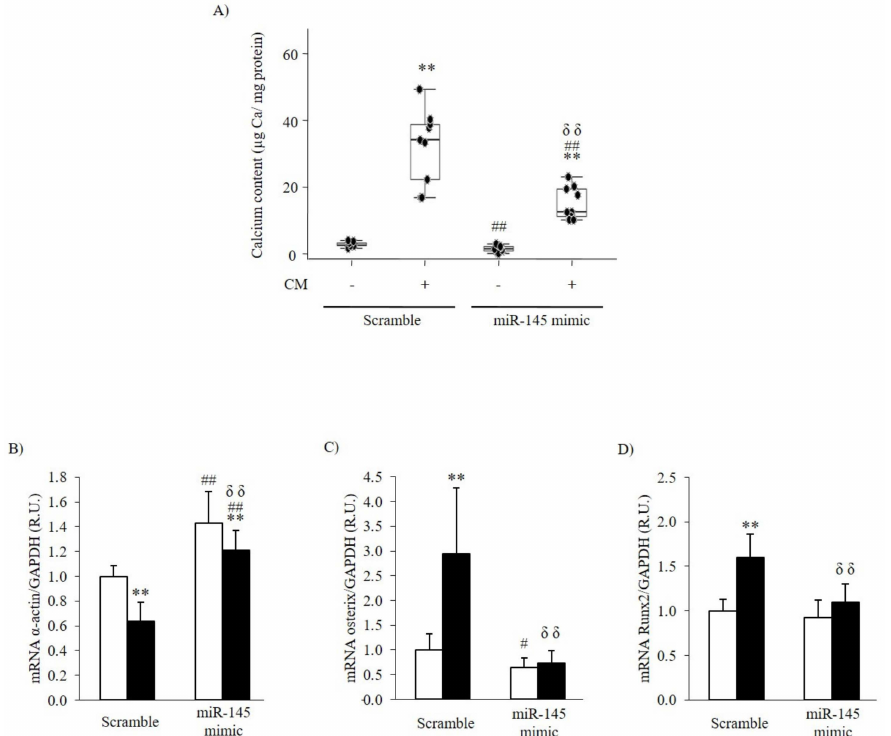
Figure 4. Overexpression of miR-145 in VSMC on calcification and osteogenic differentiation. ( A ) Ca deposition in A7r5 cells transfected with Scramble or miR-145 mimic and exposed to either non calcifying media (CM-) or calcifying media (CM+) for 4 days. Box plots represent median and interquartile range from three independent experiments performed in triplicate per experimental condition. ( B ) α –actin, ( C ) osterix and ( D ) Runx2 mRNA levels in A7r5 cells transfected with